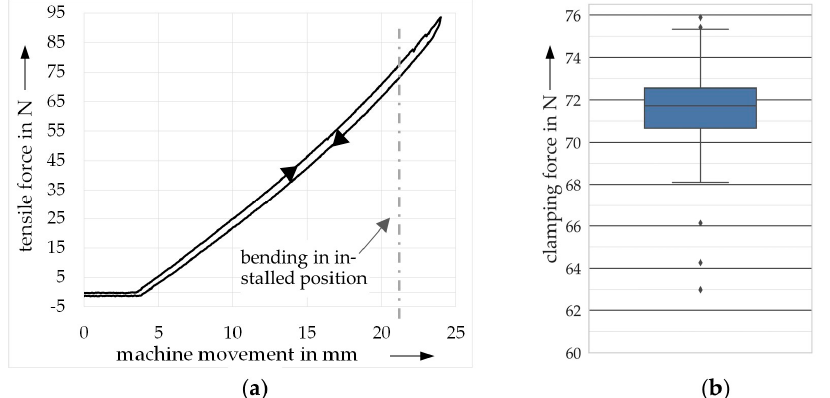
Figure 6. ( a ) Measured tensile force that is required for increasing and decreasing machine movement for one selected sample of newly manufactured clamps; ( b ) Boxplot with median, upper and lower quartile; respective whiskers, and outliers of clamping force (the tensile force that is applied at the installed position of the clamp) for 85 newly manufactured clamps.